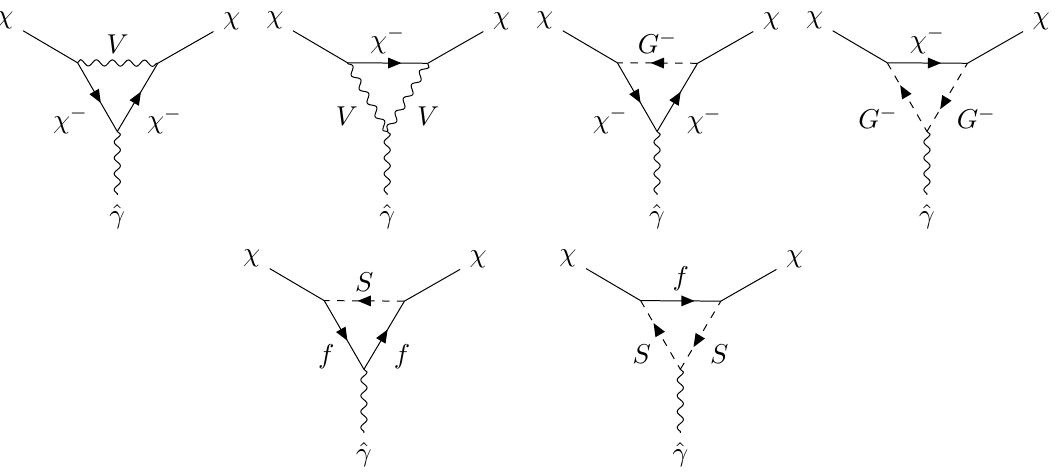
Figure 1. Feynman diagrams generating an anapole moment for a Majorana fermion at the one- loop level in the background field formulation, via the mediation of an electrically charged vector boson (top) or the mediation of a charged scalar (bottom).